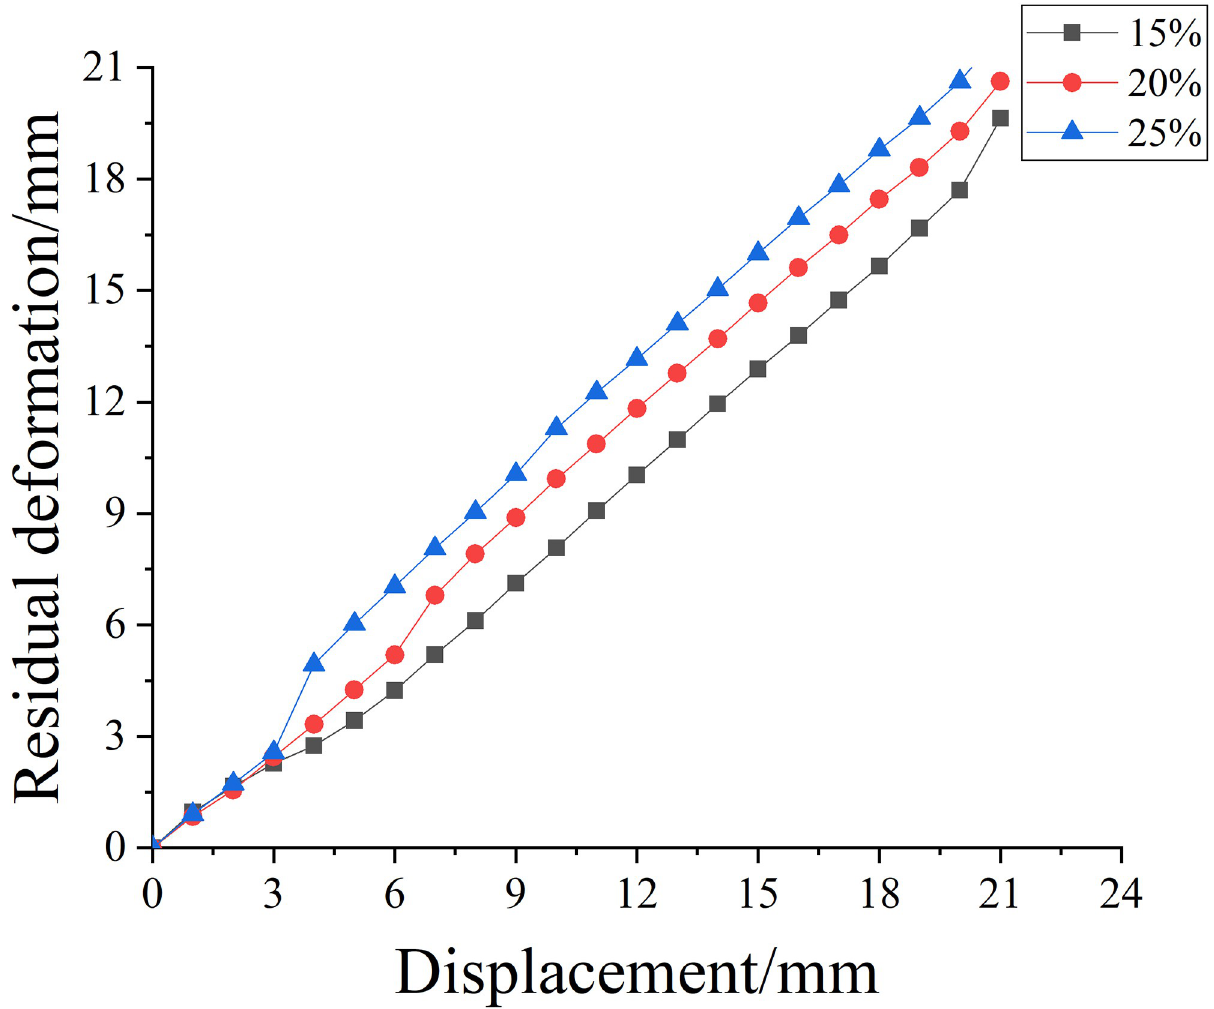
Fig 13. Residual deformation curves of reinforced concrete columns strengthened with SMA with different salt solution concentrations.